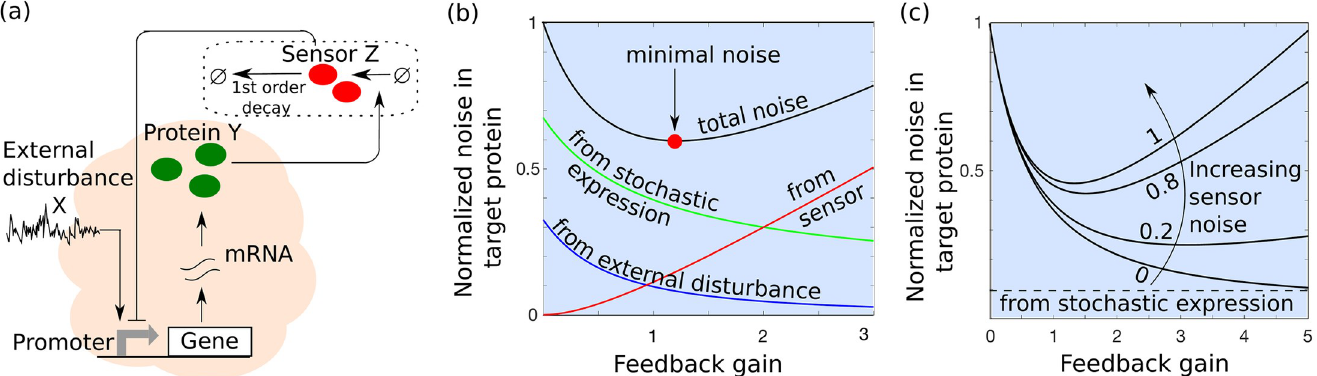
Fig 2. Implementation and noise decomposition for a proportional feedback controller. (a) Schematic of a proportional controller where the protein Y is sensed by a noisy sensor Z that inhibits the synthesis of Y . (b) Different components in the noise levels of protein Y from (30) plotted as a function of the feedback gain f p . While feedback selectively attenuates noise due to external disturbance and stochastic expression of Y , it amplifies the sensor noise, leading to a non-monotonic profile for the total noise. The noise contribution from the external disturbance decreases rapidly as a function of f p and approaches zero for f p ! 1 . In contrast, the intrinsic noise decreases slowly and asymptotically approaches a non-zero limit. In this plot, noise levels are normalized to the open-loop noise ( f p = 0), with other parameters chosen as CV 2 ¼ 0 : 4 , CV 2 ¼ CV 2 ¼ 0 : 2 , γ z = 5 γ y = 15 γ x . (c) The normalized total noise in Y from (30) with respect to the feedback gain f p for different levels of sensor noise. Z int X The total noise CV 2 is minimized at an optimal feedback gain, which critically depends on the extent of sensor noise CV 2 Y